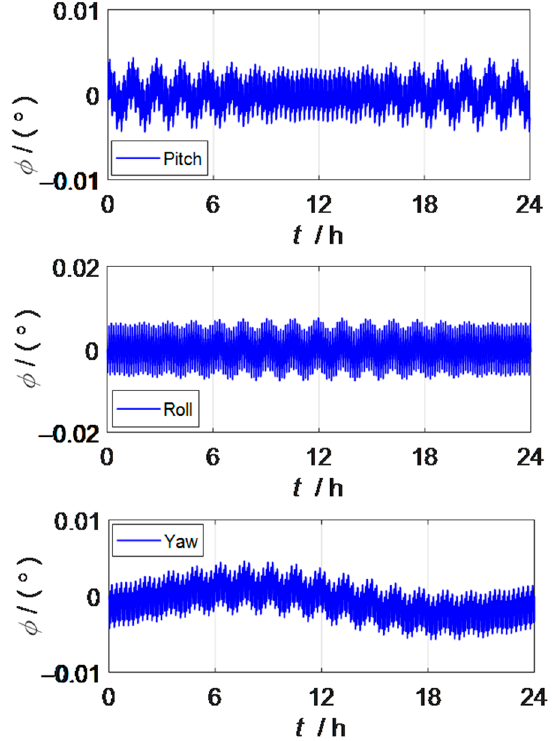
Figure 3. Attitude error of the rotation strapdown inertial navigation system.